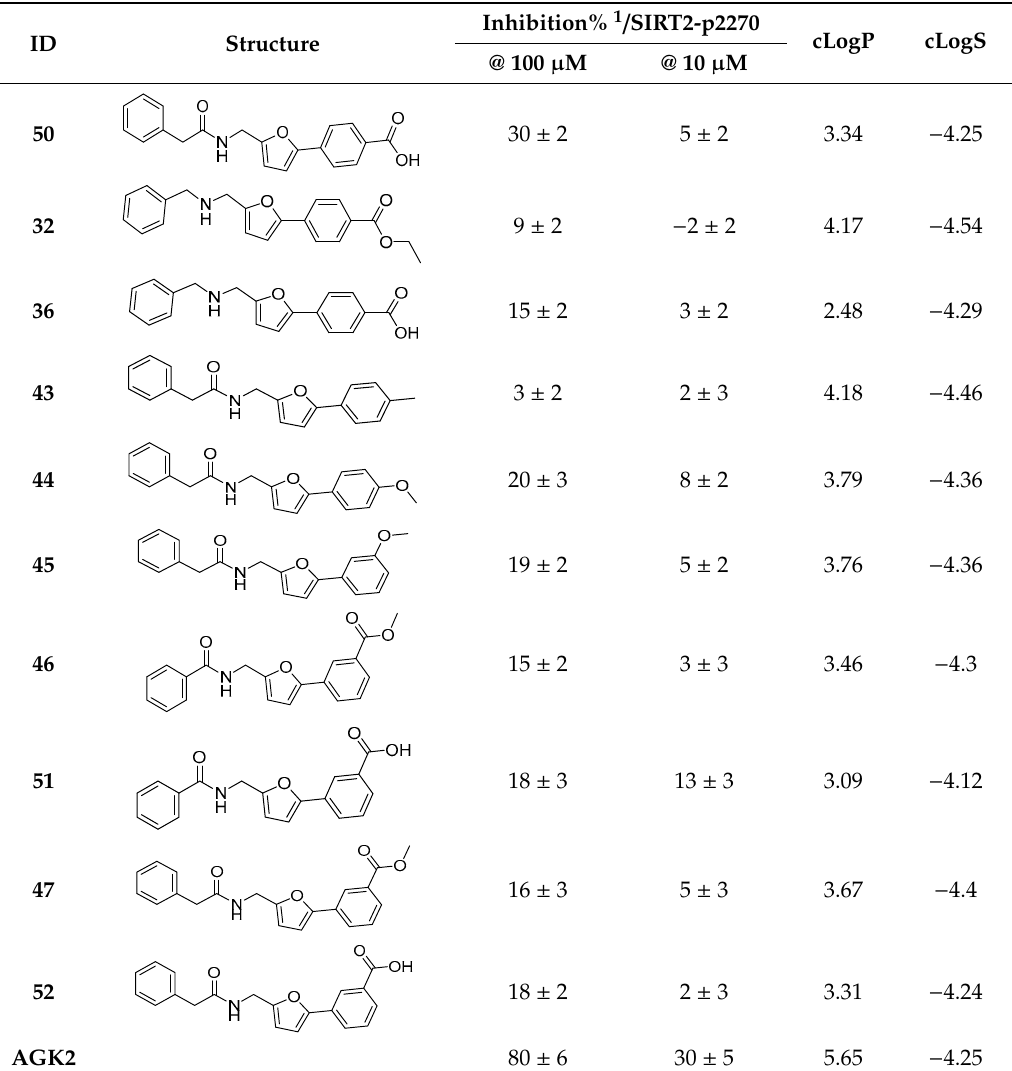
Table 2. The inhibitory activities and calculated clogP/clogS values of compounds 17 – 18 , 23 – 26 , 33 – 34 , 37 and 48 against human SIRT2.